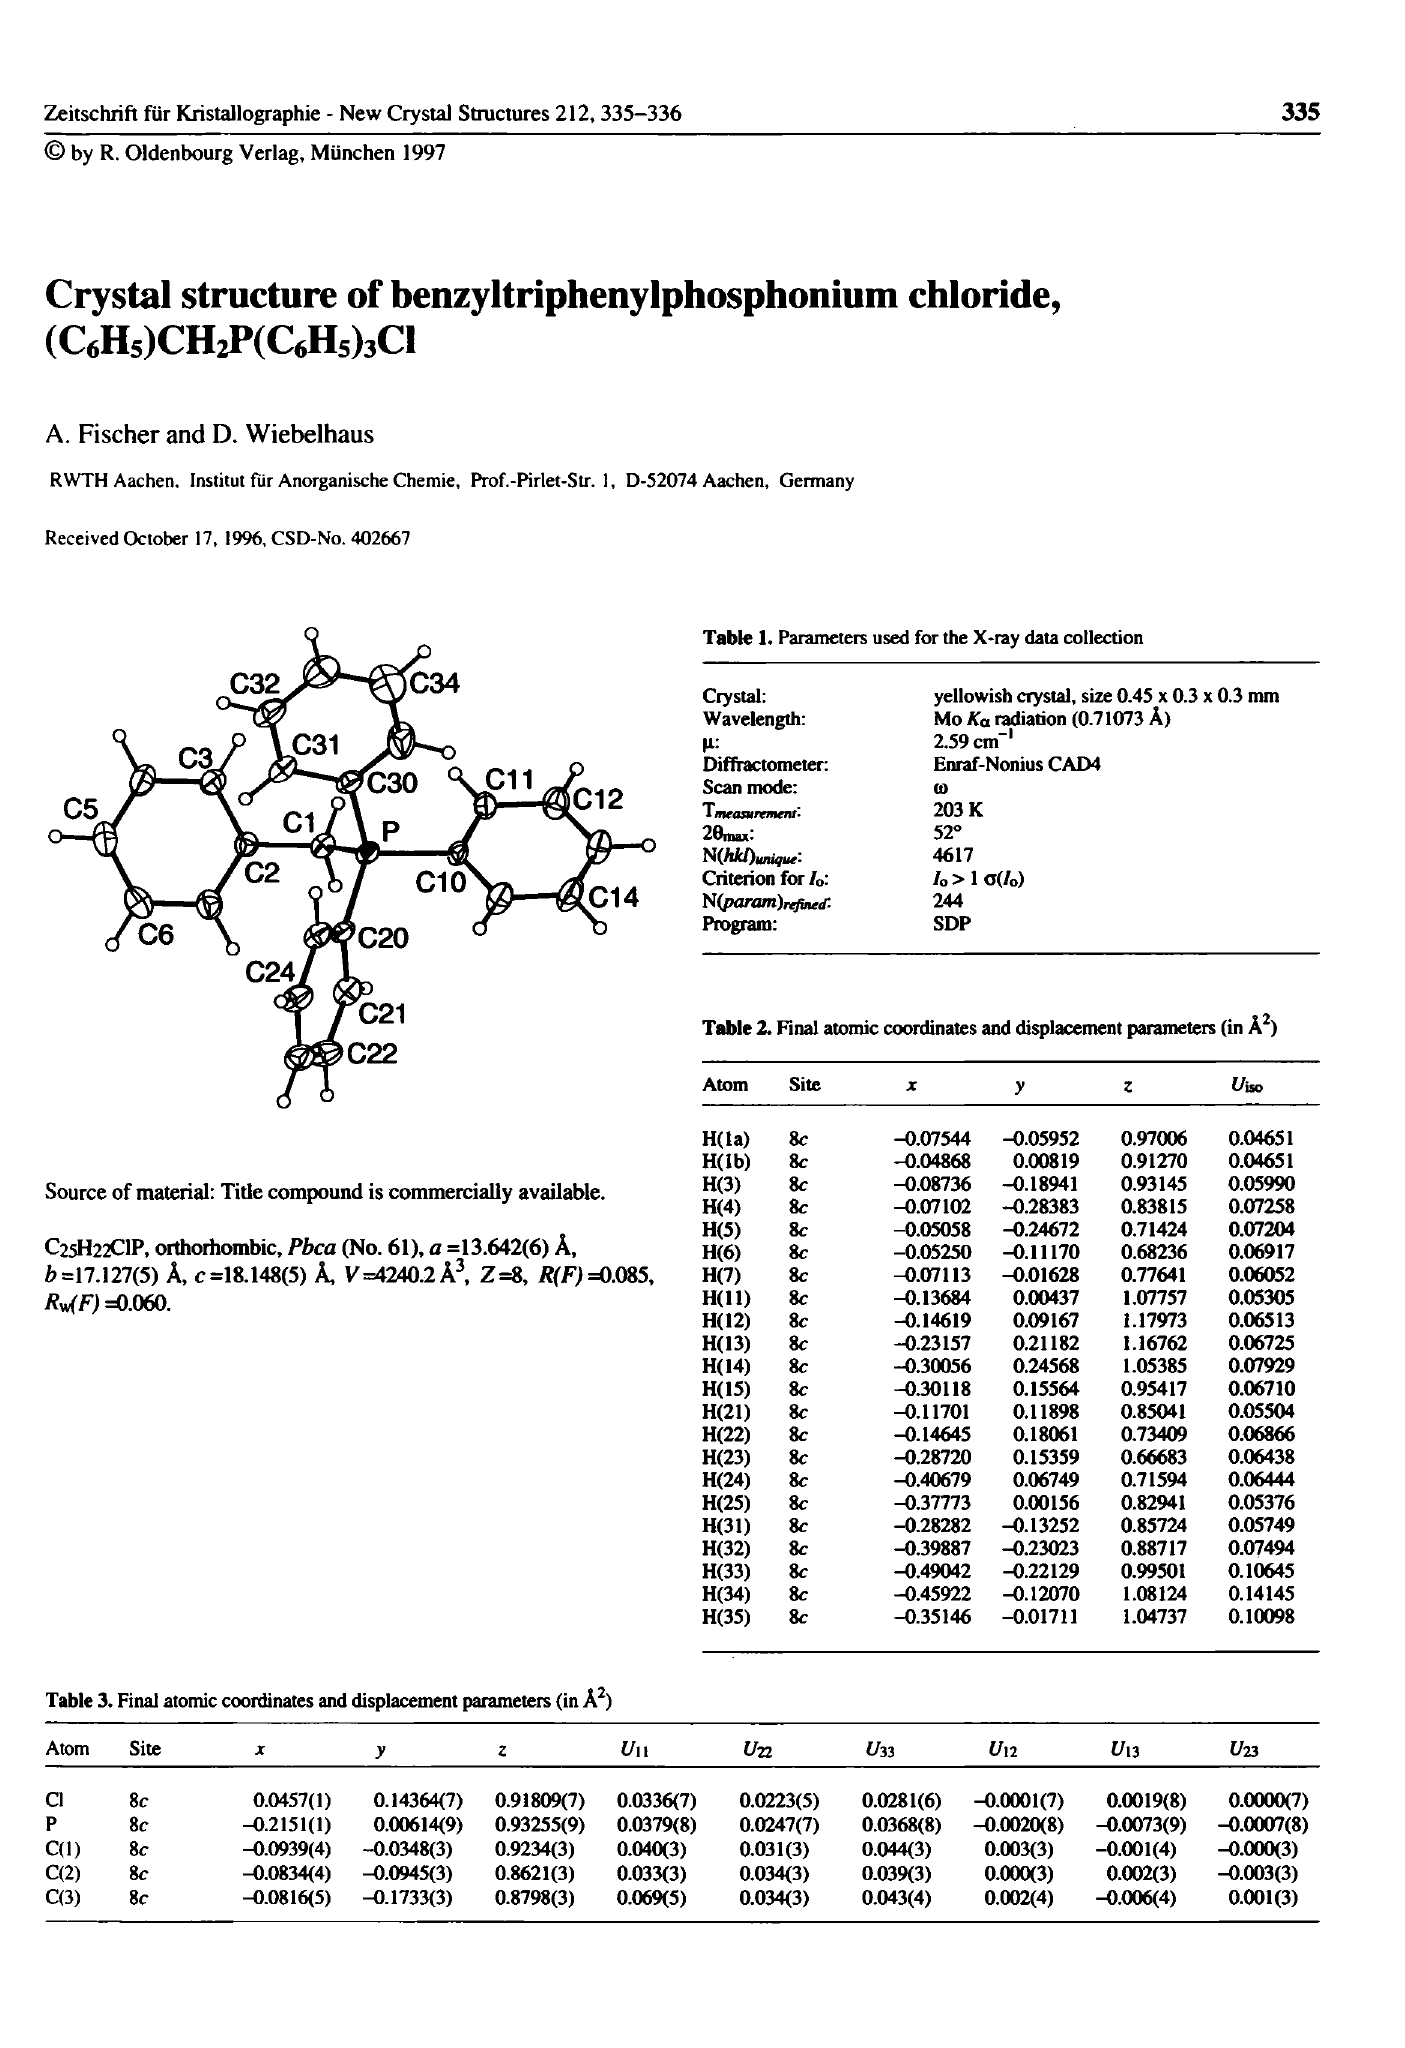
Table 3. Final atomic coordinates and displacement parameters (in Â 2